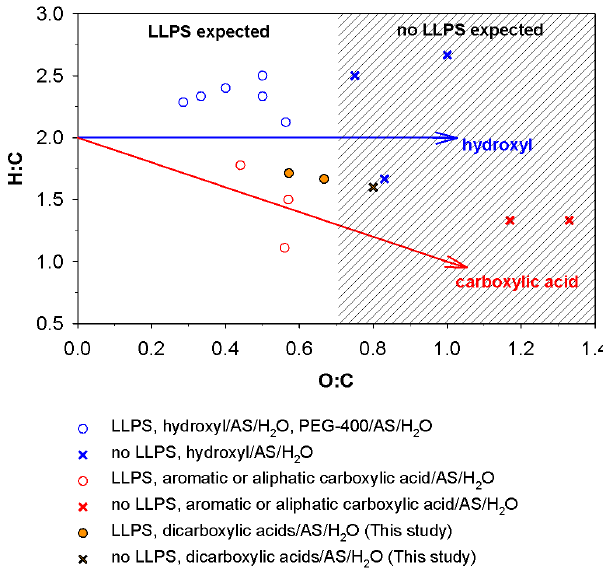
Fig. 11. Van Krevelen diagram showing organic/AS/H 2 O systems with LLPS (circles) and without LLPS (crosses) from previous work (Marcolli and Krieger, 2006; Zuend et al., 2008; Ciobanu et al., 2009; Bertram et al., 2011, see Table 2 for the datasets) and this study (orange symbols). The blue and red arrows cor- respond to the addition of hydroxyl and carboxylic acid (or hy- droxyl+ketone/aldehyde) functional groups to an alkane backbone, respectively, as discussed in Heald et al.